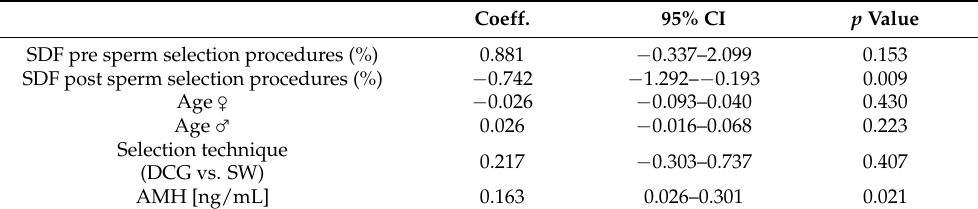
Table 6. Coefficients, significance, partial frame age and observed power of the univariate linear model analysis (dependent variable: viable